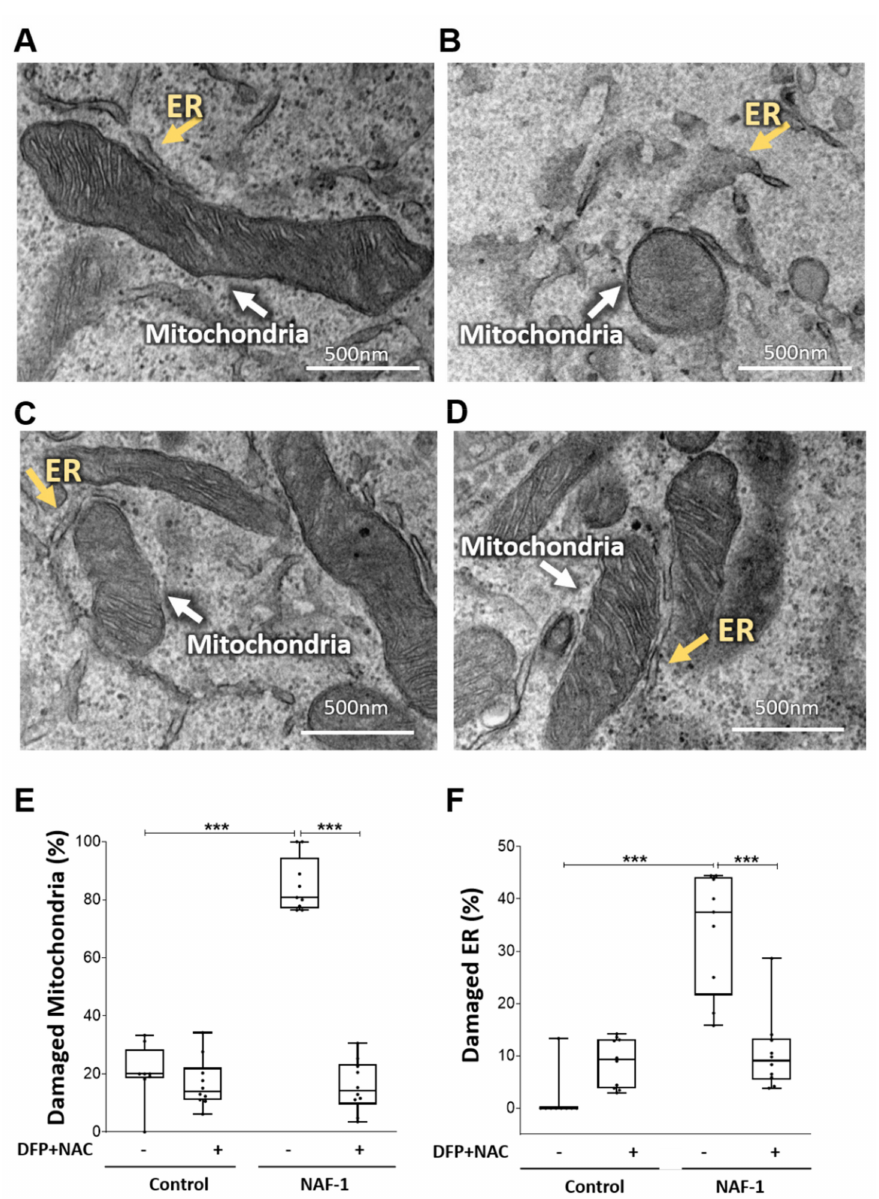
Figure 7. Pharmacological amelioration of mitochondrial and ER morphology in NAF-1( − ) INS-1E cells with a combined DFP and NAC treatment. ( A–D ) Representative TEM images of control and NAF-1( − ) INS-1E cells treated or untreated with a NAC (100 µ M) + DFP (50 µ M) combination (A, Control. ( B ) NAF-1( − ). ( C ) Control treated with DFP+ NAC. ( D ) NAF-1( − ) treated with DFP+ NAC). Yellow and white arrows indicate ER and mitochondria, respectively. ( E , F ) Statistical analysis of mitochondrial ( E ), or ER ( F ), damage in NAF-1( − ) INS-1E cells following the combined DFP+ NAC treatment. The results are shown as box-and-whisker plots and include all data points measured from three different experiments. *** p < 0.001, compared to control; Student’s t -test, N = 200 for mitochondria, N = 300 for ER. Abbreviations: DFP, deferiprone; NAC, N-acetyl